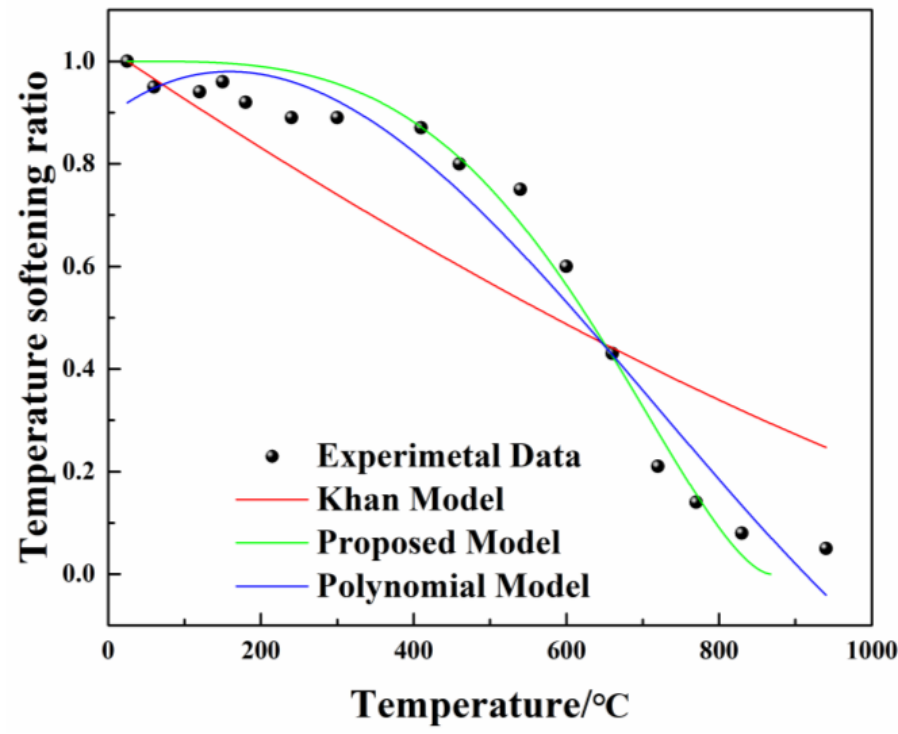
Figure 12. Experimental data and fitting curves of temperature models. Table 5. Equations of temperature models.